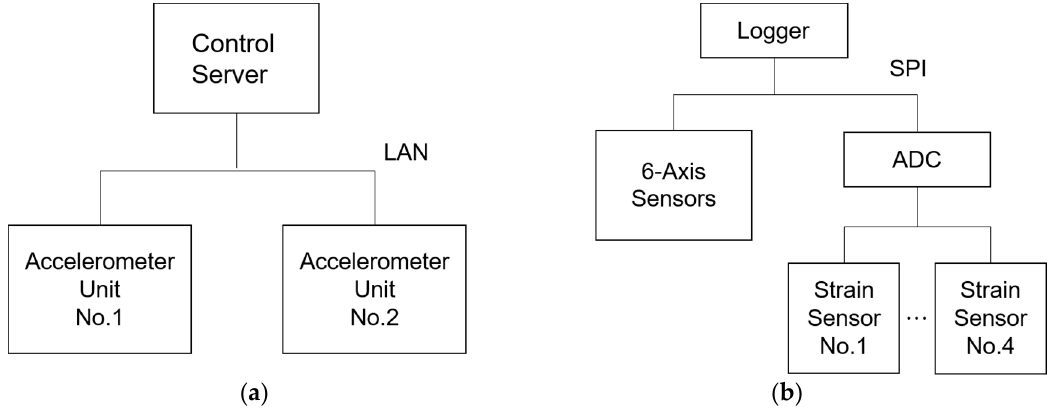
Figure 2. ( a ) system schematic diagram; ( b ) accelerometer unit [2].